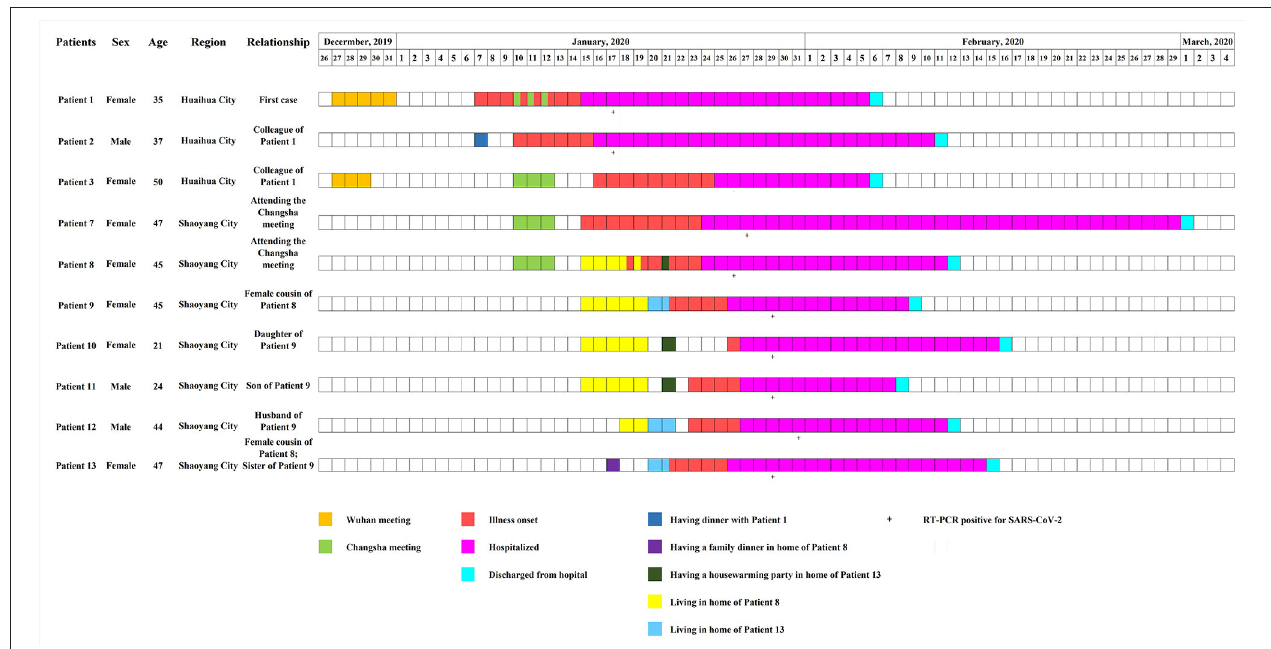
FIGURE 1 | Timeline of severe acute respiratory syndrome coronavirus 2 (SARS-CoV-2) and human adenovirus (HAdV) co-infections. Boxes of different colors specify critical events experienced by patients. From January 15 to 19, 2020, Patient 9, with both her daughter (Patient 10) and son (patient 11), stayed in the home of her cousin (Patient 8). From January 20 to 21, 2020, a couple (Patient 9 and Patient 12) lived in a new house purchased by the sister (Patient 13) of Patient 9. On January 21, a housewarming party attended by Patients 8–12 was